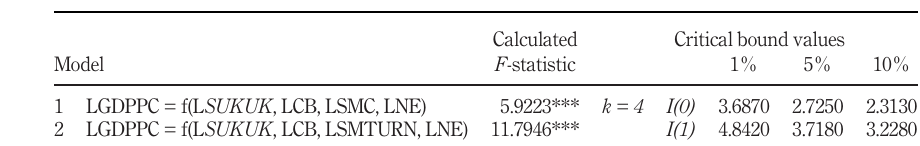
Table 4. The bounds test for cointegration